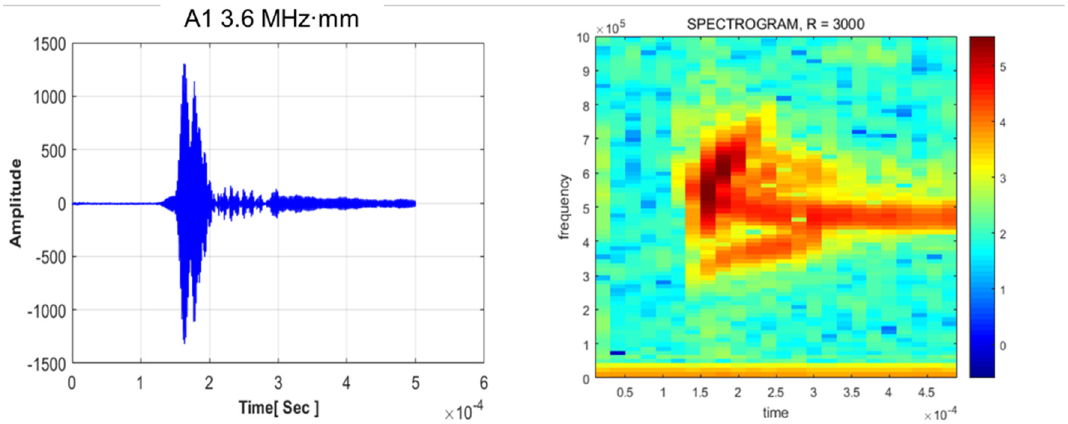
Sensors 2021 , 21 , x FOR PEER REVIEW Figure 11. STFT analysis for antisymmetric Lamb wave mode. Figure 11. STFT analysis for antisymmetric Lamb wave mode.